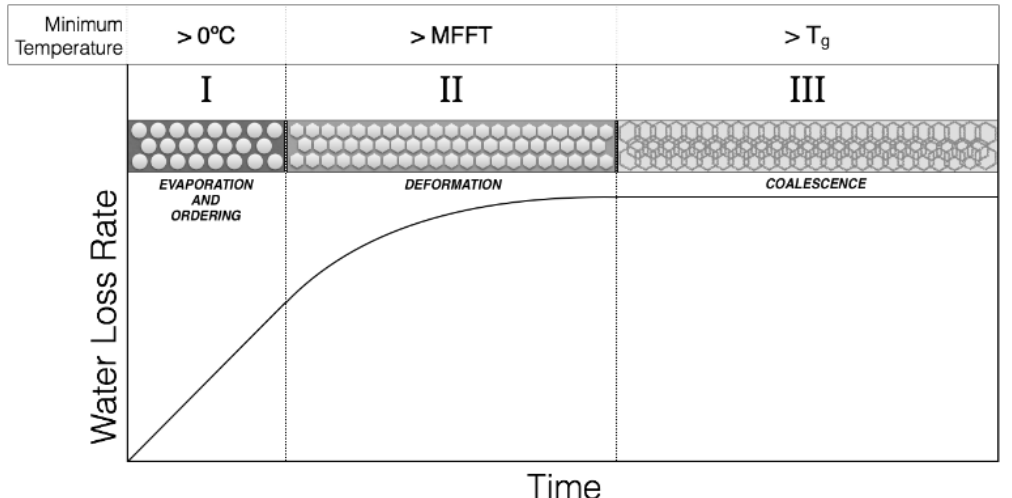
Figure 2. Film formation mechanism of polymer latex.